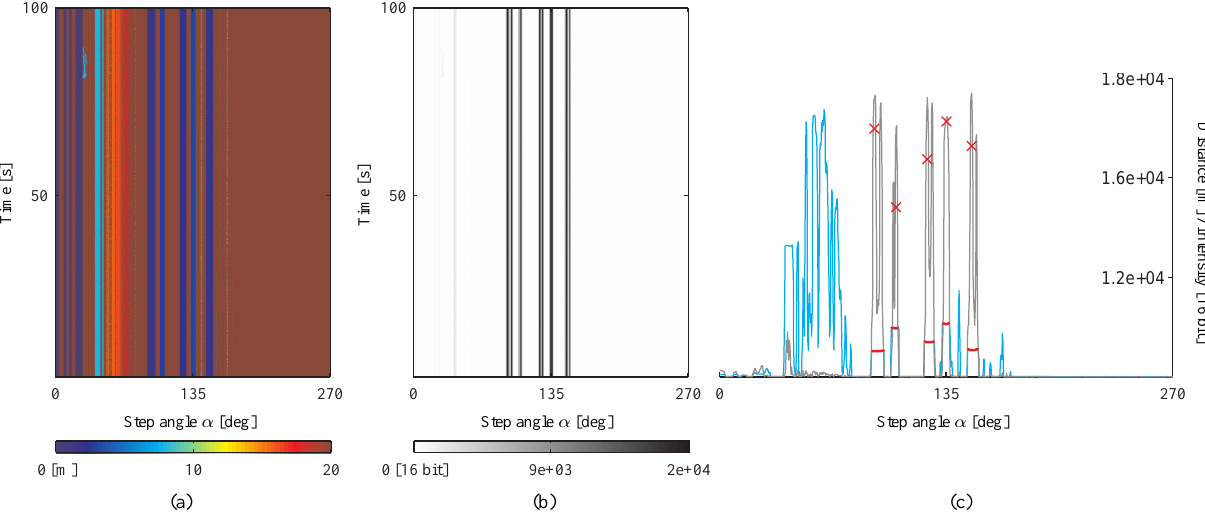
Figure 3: Part of (a) range and (b) intensity LSRF raw data captured from one position over time. The five bluish/black lines in range/intensity data (in a distance of approx. 5 m around the region of 135 deg ) clearly represent the five cones. The result of the segmentation of the cones is shown in (c): The cyan and the black curves represent the mean of the long-term measurements in distance resp. intensity channel. The red crosses roughly mark the detected cone positions, and the red lines highlight the corresponding measurement points which are introduced into the bundle